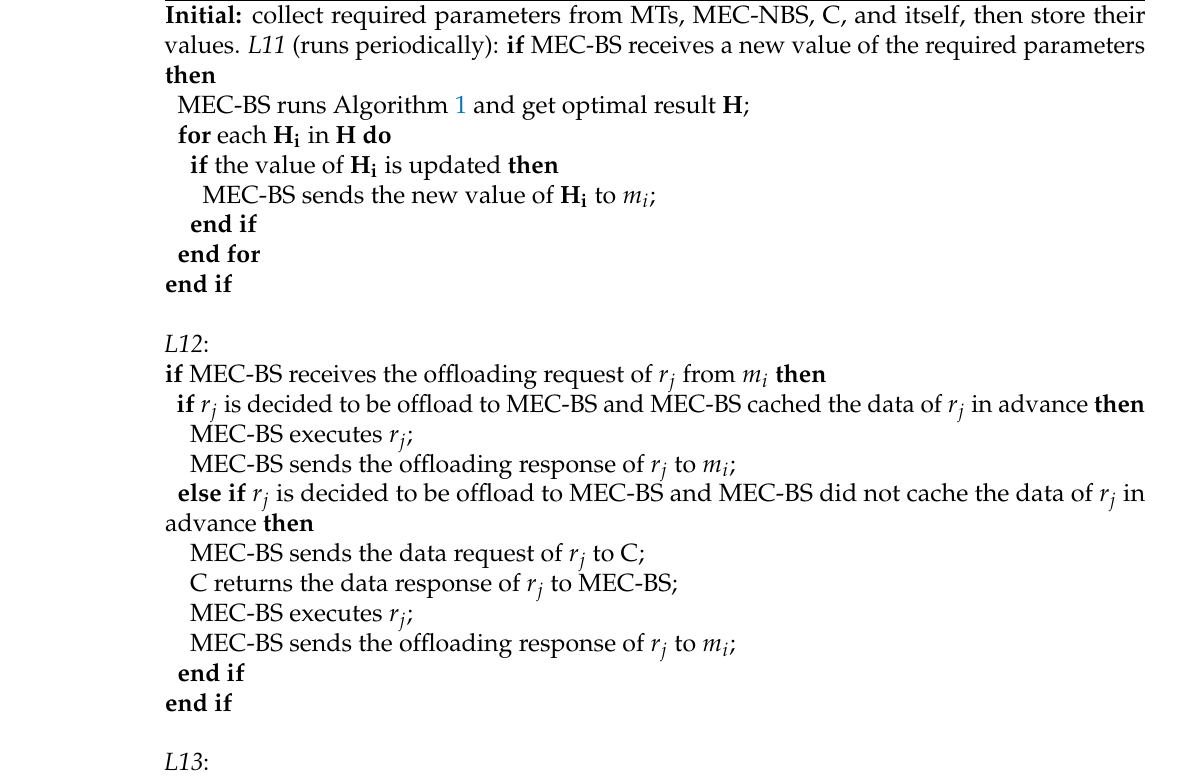
Algorithm 5 Cooperative Resource Management Algorithm at MEC-BS